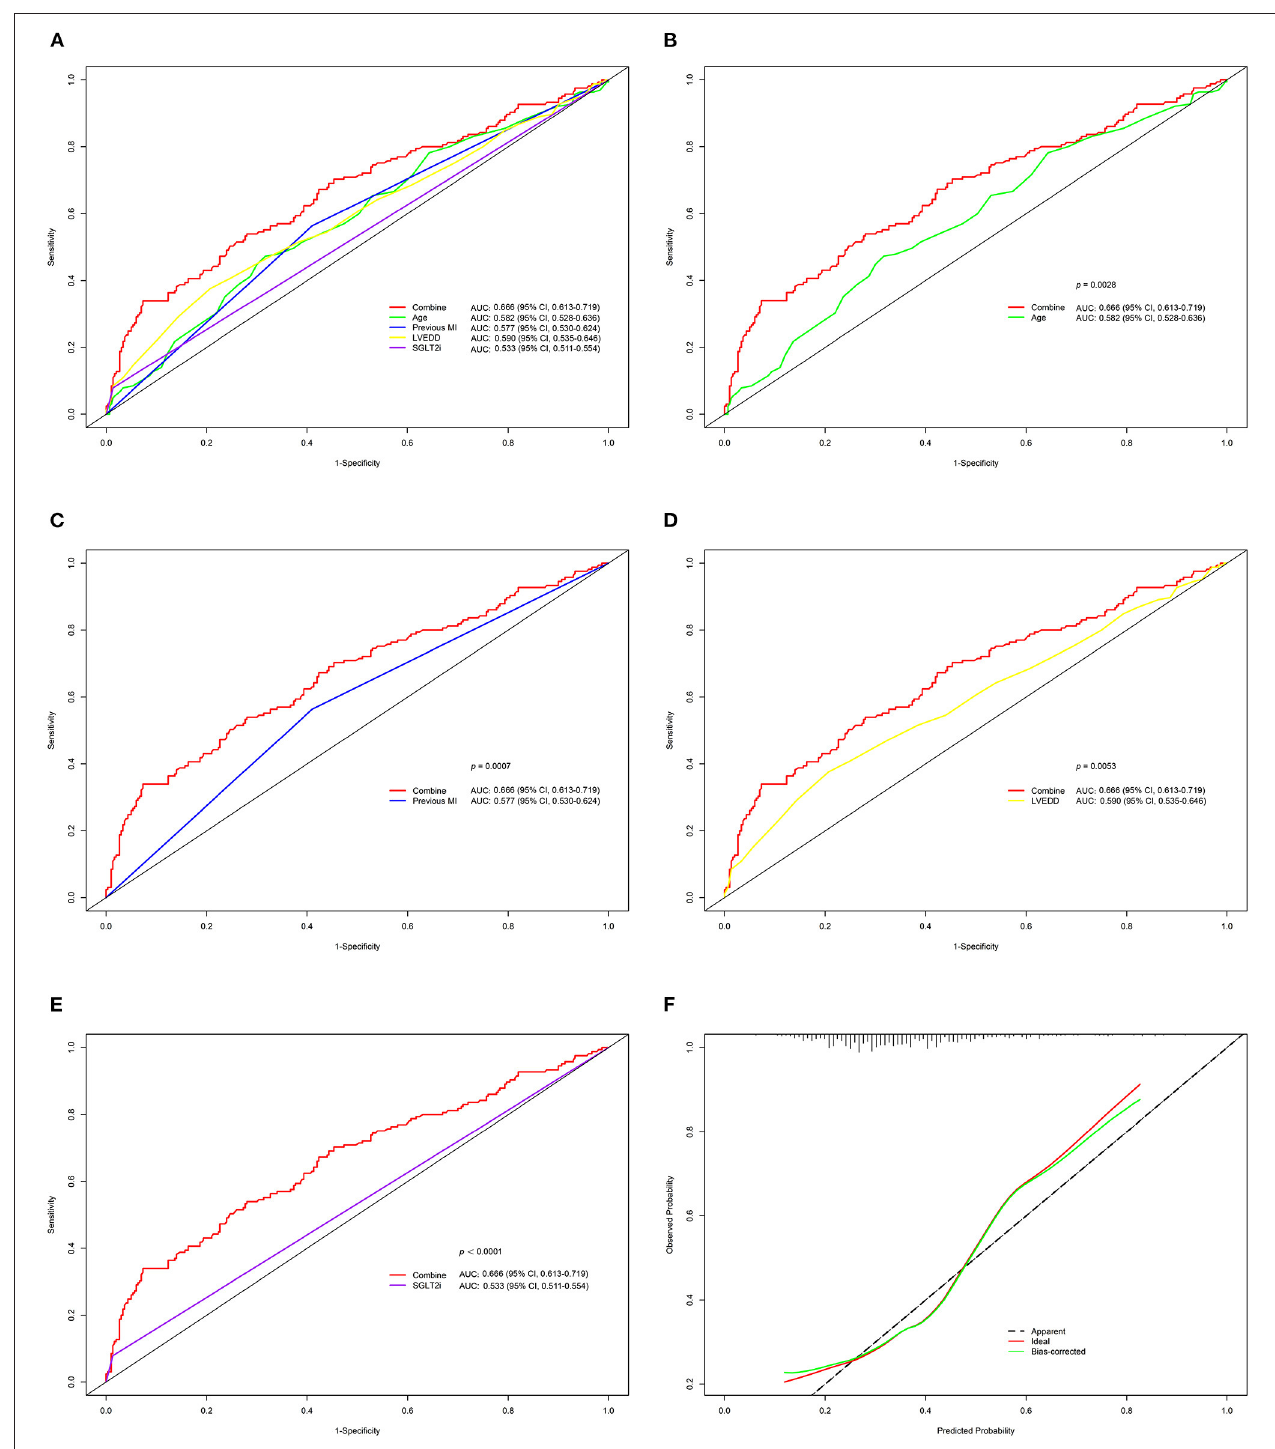
FIGURE 4 | Validation of the nomogram for HFiEF at 1 year. (A–E) Comparison of ROC and the area under the curve (AUC) for the HFiEF nomogram with each index. (F) Calibration plot for the 1,000-time resampling bootstrap analysis.